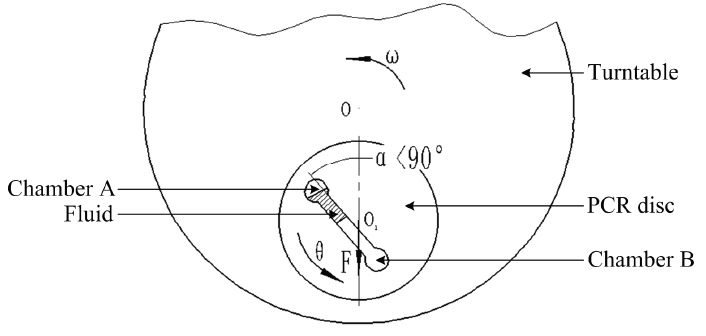
Figure 1. Working diagram of the double-shaft centrifugal microfluidic system. (F: centrifugal